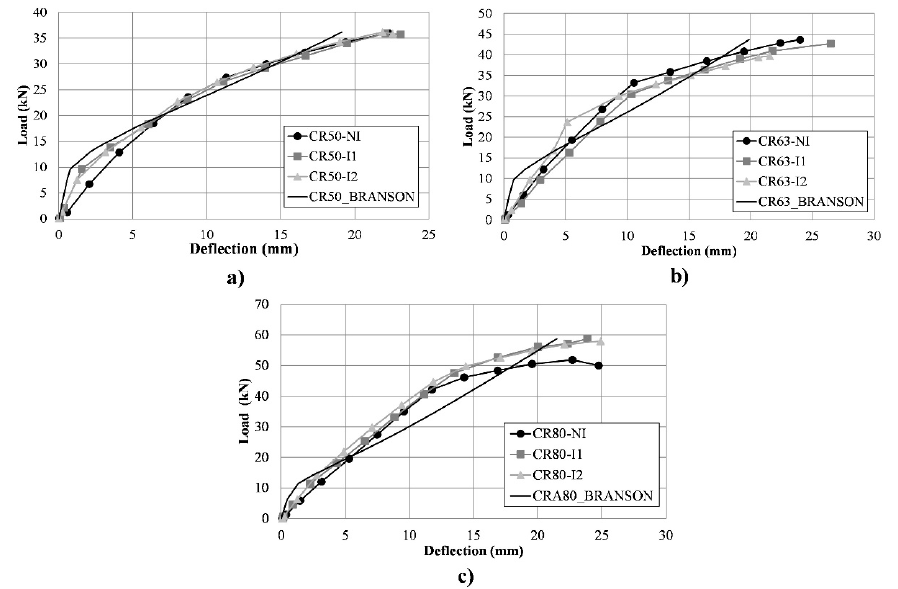
Figure 13. Load-deflection curves obtained in the bending test for beams: a) CR50; b) CR63; c) CR80. Load (kN) represents the sum of the loads (2 P ) applied to the